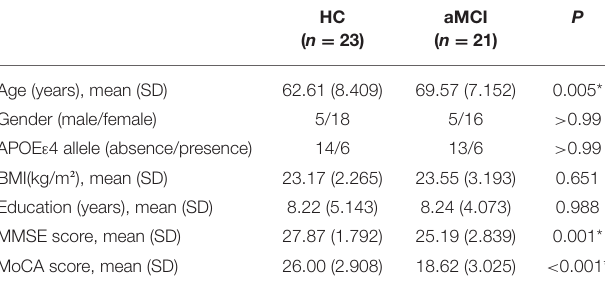
TABLE 2 | General characteristics and clinical data of HC and aMCI